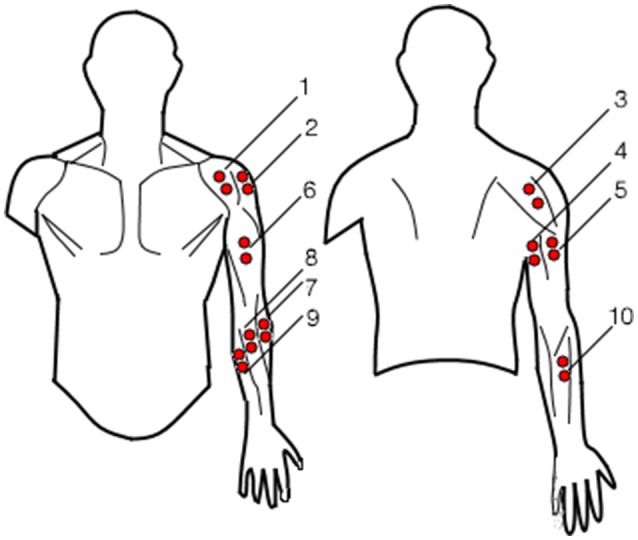
Surface electromyography electrodes placement: 1-2-3 for the anterior, lateral and posterior deltoids, 4-5 for the long and lateral trisceps brachii, 6 for the biceps, 7-8-9 for the brachioradialis, flexor carpi radialis and ulnaris respectively and 10 for extensor digitorum.